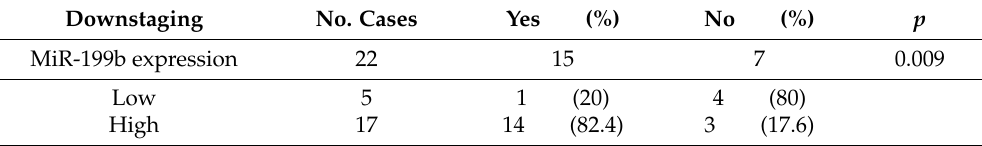
Table 3. Association between downstaging and miR-199b expression in liquid biopsies from LARC patients. Downstaging No.